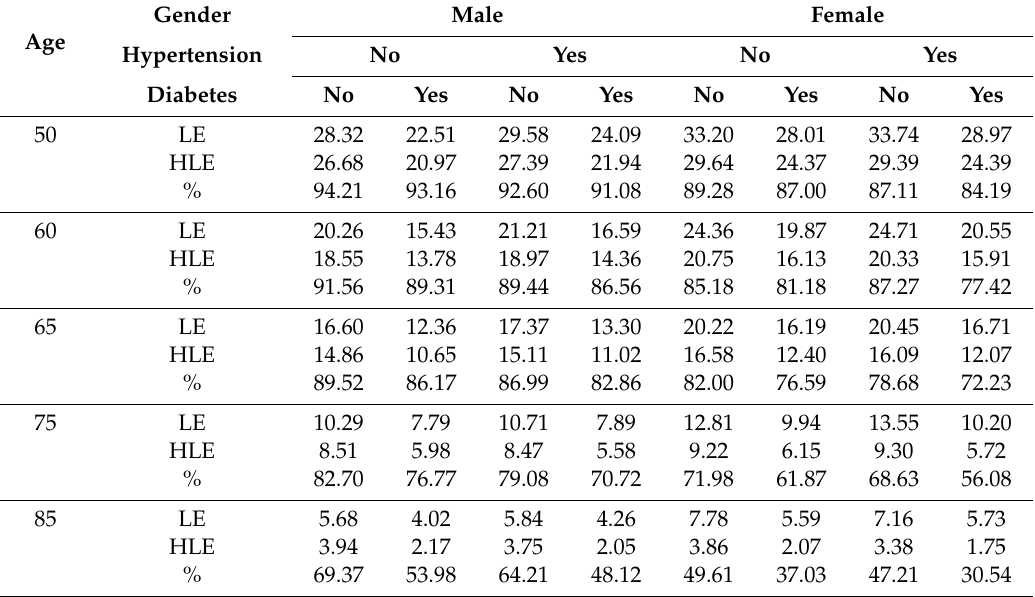
Table 3. Association outcomes of respondents who were middle-aged and over in Taiwan.